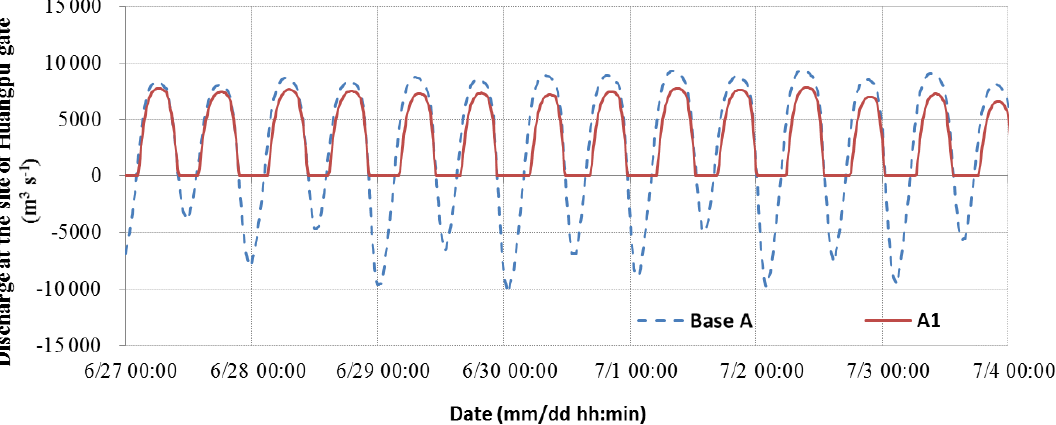
Figure 11. Comparison of discharges at the site of the proposed gate between scenarios Base A and A1 from 27 June to 3 July in 1999 (the negative discharges mean the tidal water